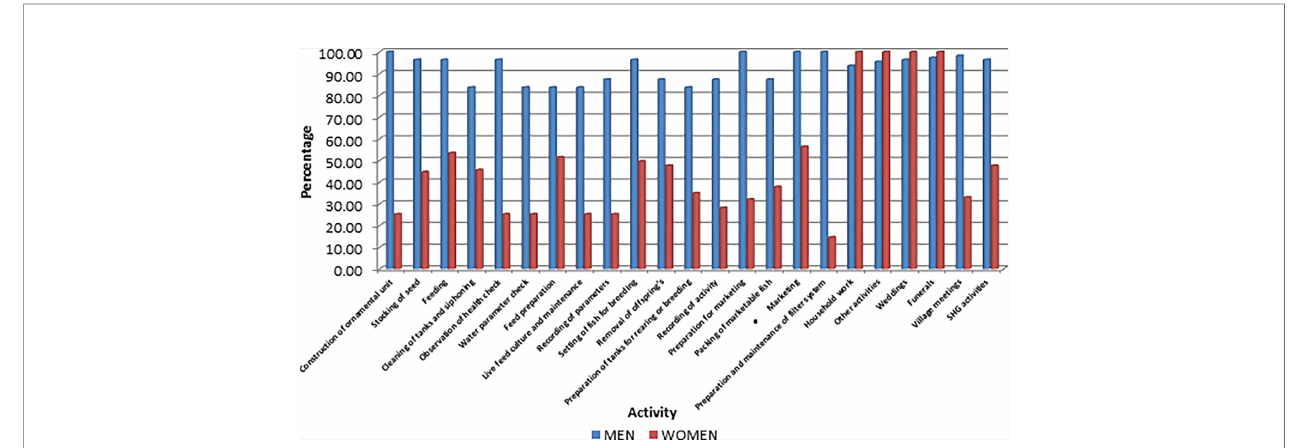
FIGURE 2 | Activity pro fi le (participation) of men and